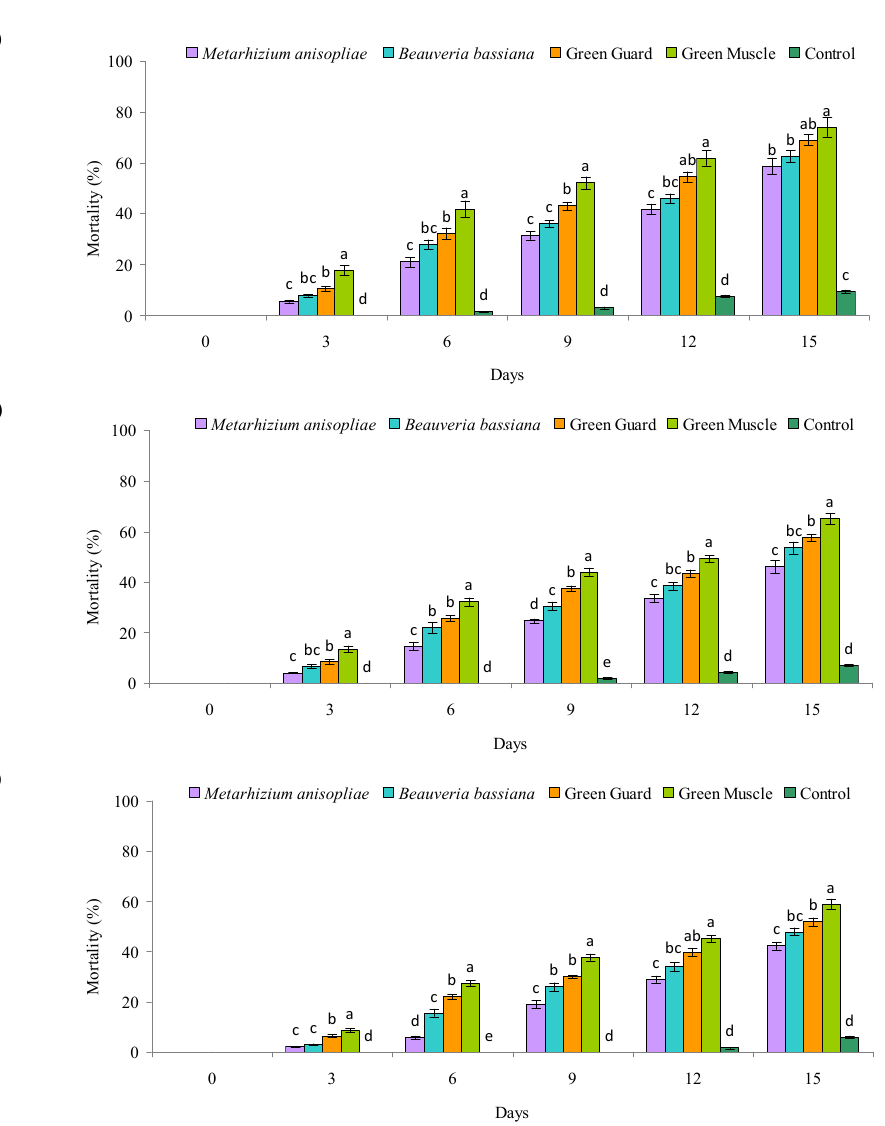
Figure 6. Mean mortality percentages ( ± SE) of ( a ) 3rd-instar, ( b ) 5th-instar and ( c ) adult S. gregaria sprayed with 1 × 10 9 conidia/mL of Green Muscle, Green Guard, B. bassiana , or M. anisopliae using a knapsack sprayer in field cages. Within each subfigure and between the treatments, different letters indicate significant differences (Tukey’s HSD test at p ≤ 0.05).